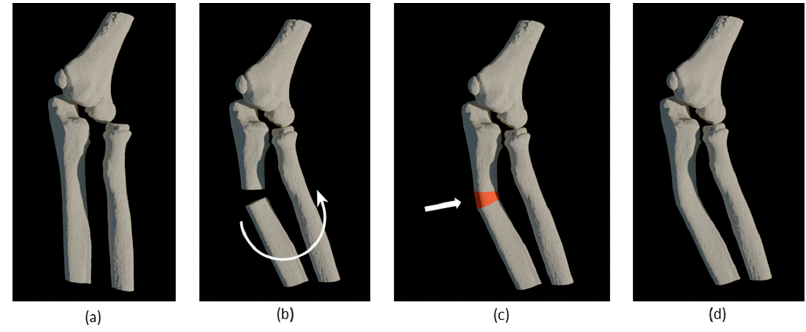
Figure 2. Video animation of the first case study: ( a ) initial configuration; ( b ) cut and rotation; ( c ) insertion of bone wedge; ( d ) final